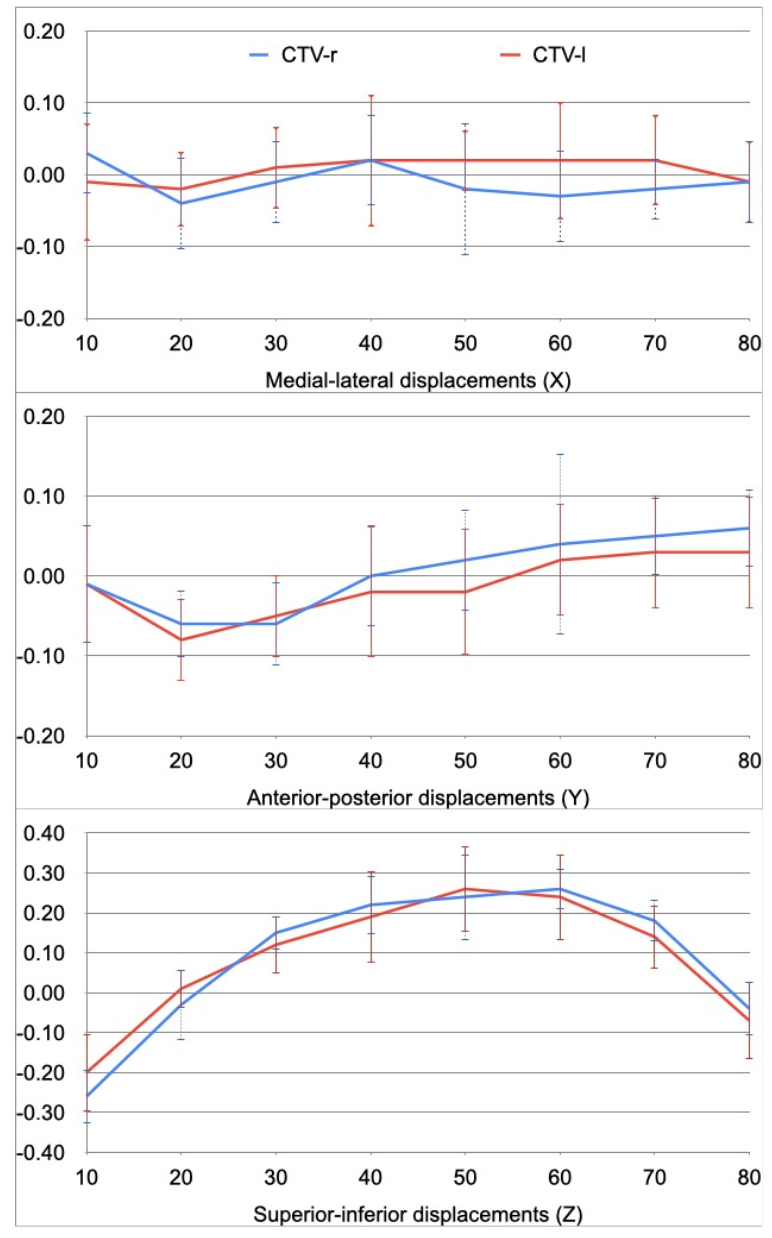
Figure 3. Displacements of CTVs (right CTV-r and left CTV-l) and standard deviation. However, only S-I movements reported a motion amplitude of 0.6 cm; for M-L and A-P, an amplitude of 0.1 cm was documented. (right plus left), and PTVs (right plus left) were 23.6 cc, 44.32 cc, and 62.9 cc, respectively, while the mean prescription isodose level and D2% were 76.5% and 31.2 Gy, respectively.